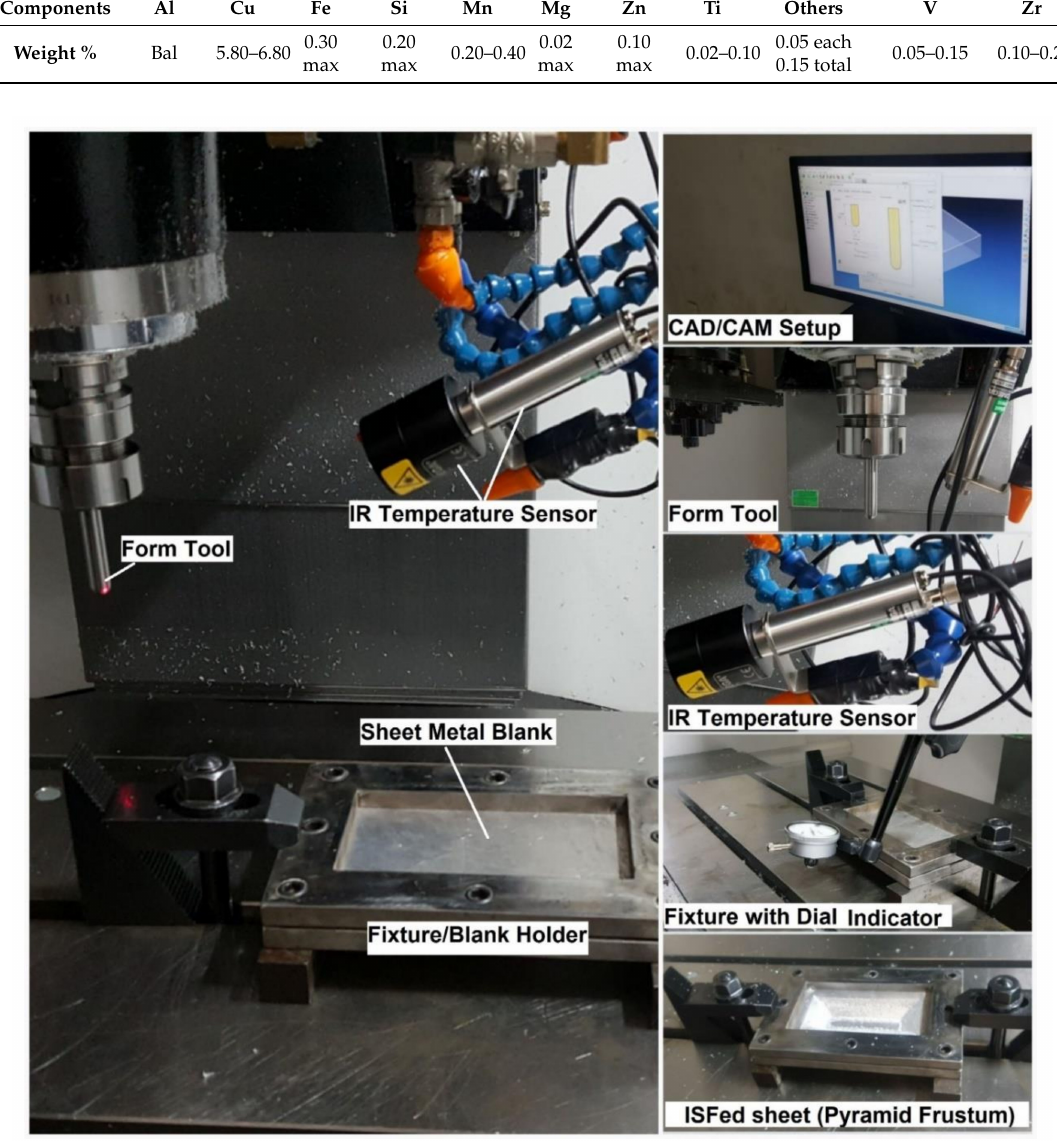
Figure 2. ISF process